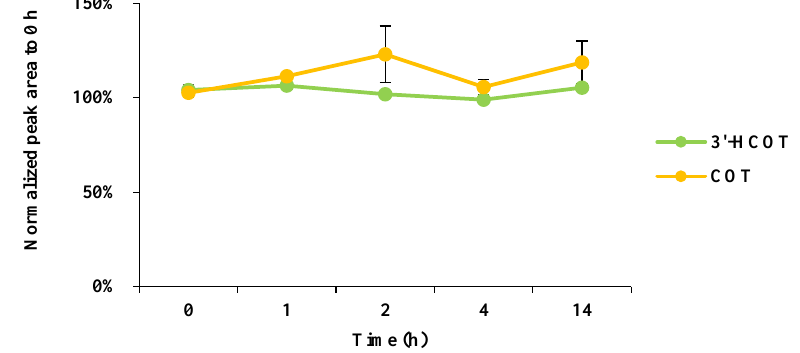
Figure 1. E ff ect of digestion time in 1 M NaOH on stabilities of COT and 3-HCOT ( n = 3). Peak areas were normalized with respect to the corresponding peak areas obtained at 0 h.